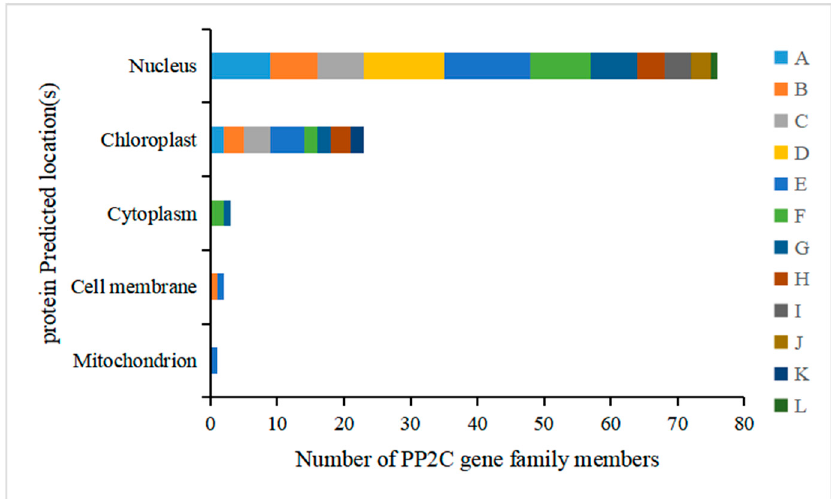
Figure 1. Prediction of subcellular localization.